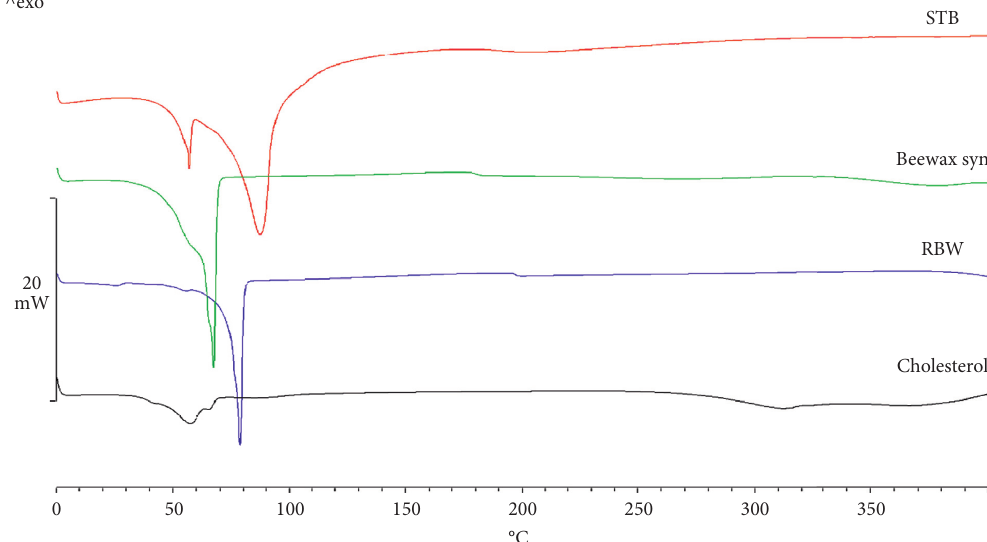
Figure 3: Thermogram of stingless bee wax, synthetic bee wax, rice bran wax, and cholesterol, respectively, by Differential Scanning Calorimeter.